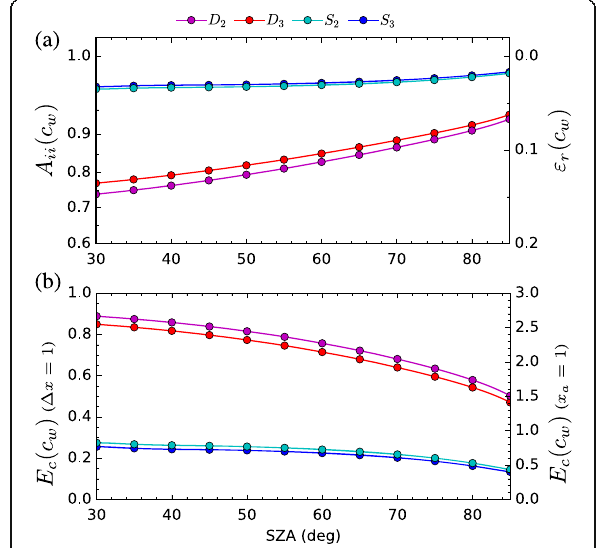
Fig. 14 a Diagonal elements of AKM and error ratio of TCWV. As compared with DSR, SSR results show stronger dependence on observation data of c w rather than a priori data. b Combined propagation errors of TCWV. The left and right scales are normalized so that Δ x = 1 and x a = 1, respectively